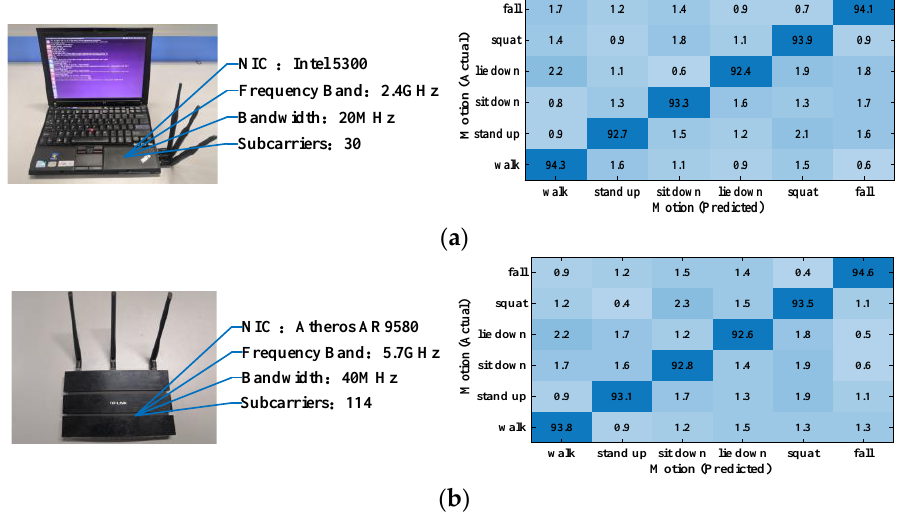
Figure 14. Cross-platform validation: ( a ) Intel 5300 NIC Platform; ( b ) Atheros AR9580 NIC Platform.